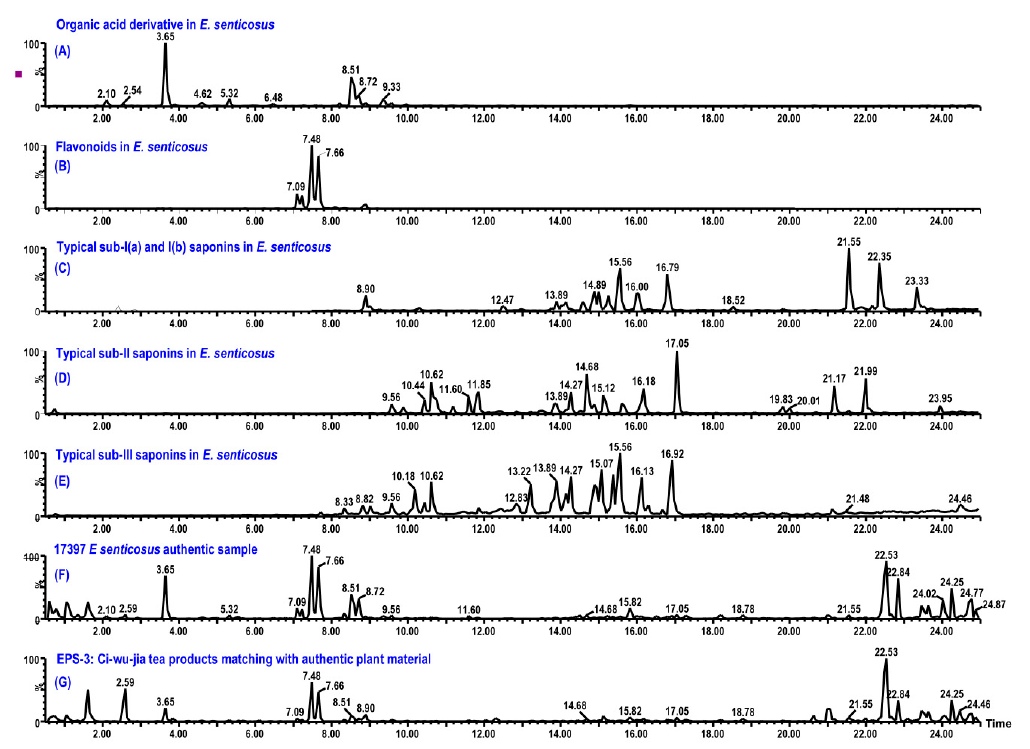
Figure 4. Chromatograms of organic acid derivatives ( A ), flavonoids ( B ), sub-I(a) and I(b) saponins ( C ), sub-II saponins ( D ), sub-III saponins ( E ), #17397 E. senticosus authentic plant sample ( F ), and typical Ci-wu-jia tea product (EPS-3) matching with plant material ( G ).